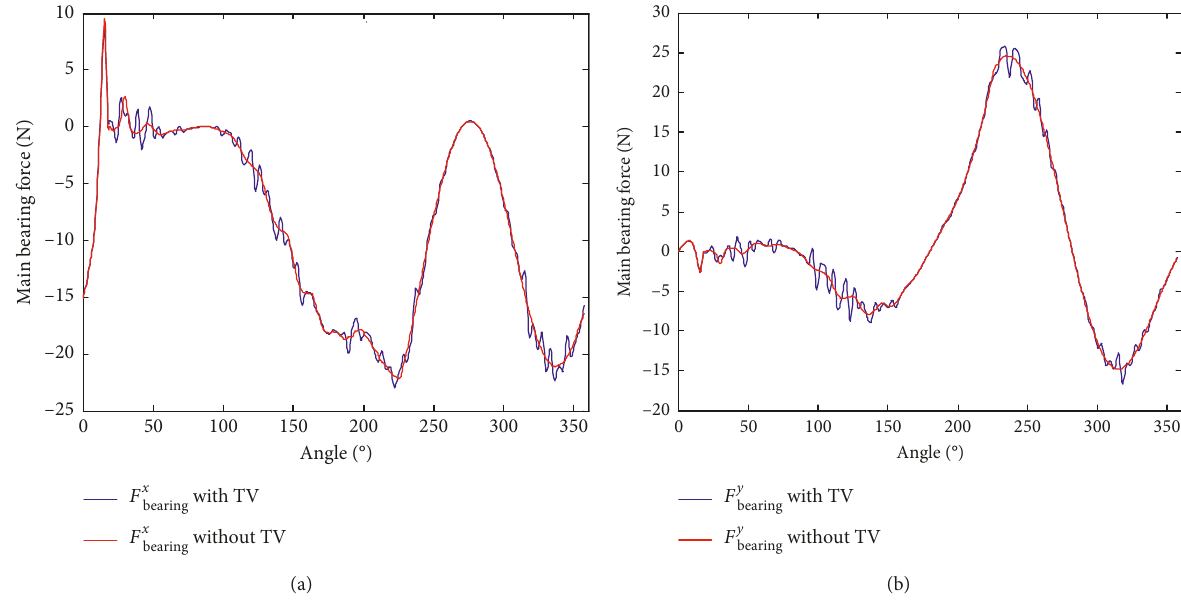
Figure 10: Main bearing reacting force with and without TV.